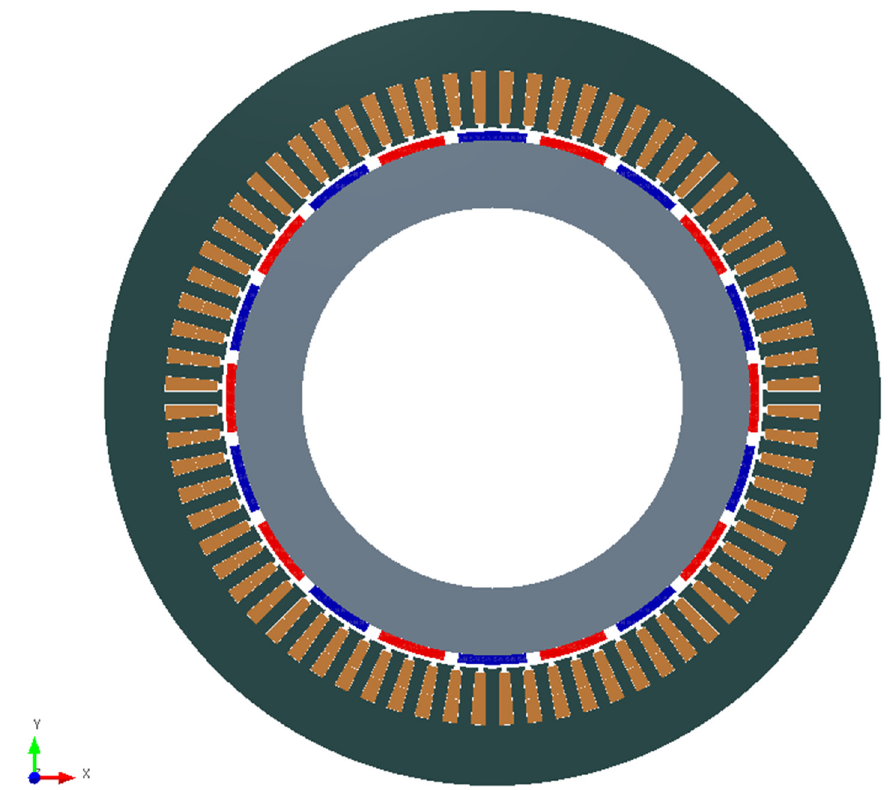
Figure 18. Generator cross-section.